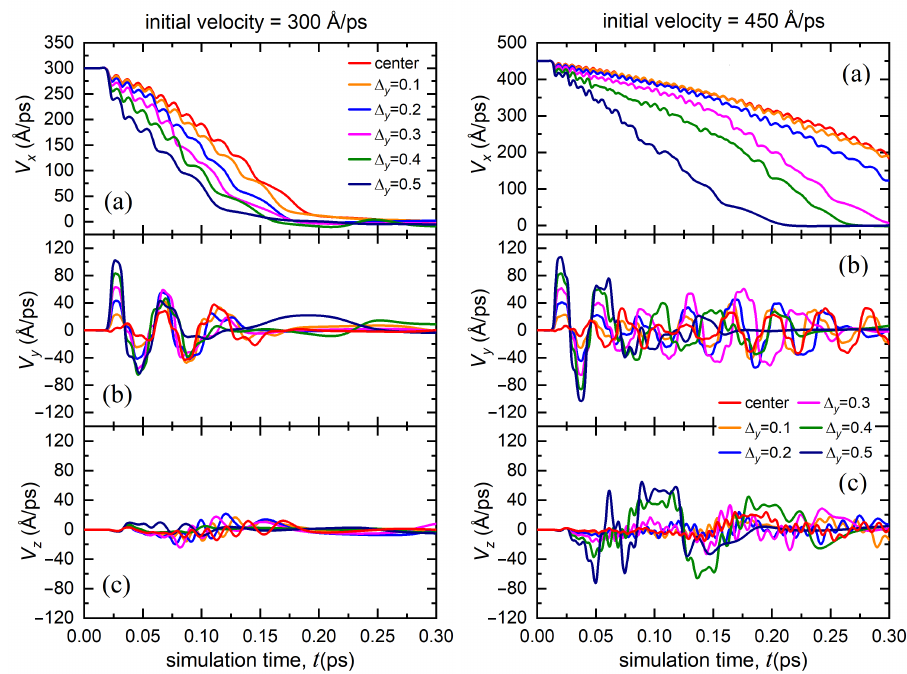
Figure 3. Dependence of the velocity components of the bombarding atom ( a ) V x , ( b ) V y , ( c ) V z on the simulation time calculated for various displacements of the atom along the y axis from the center of the octahedral channel (case II). The results are presented for two values of the initial velocity of the bombarding atom excited according to scenario two: 300 Å/ps (left panel) and 450 Å/ps (right